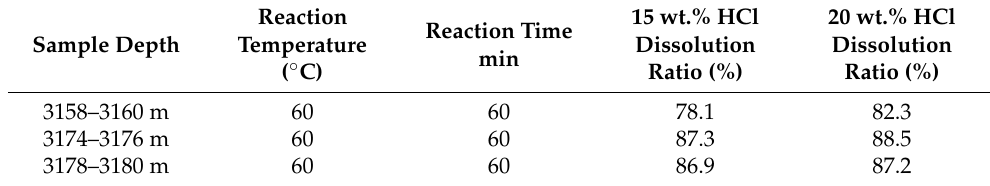
Table 6. Experimental results of the rock debris dissolution for different acid concentrations.